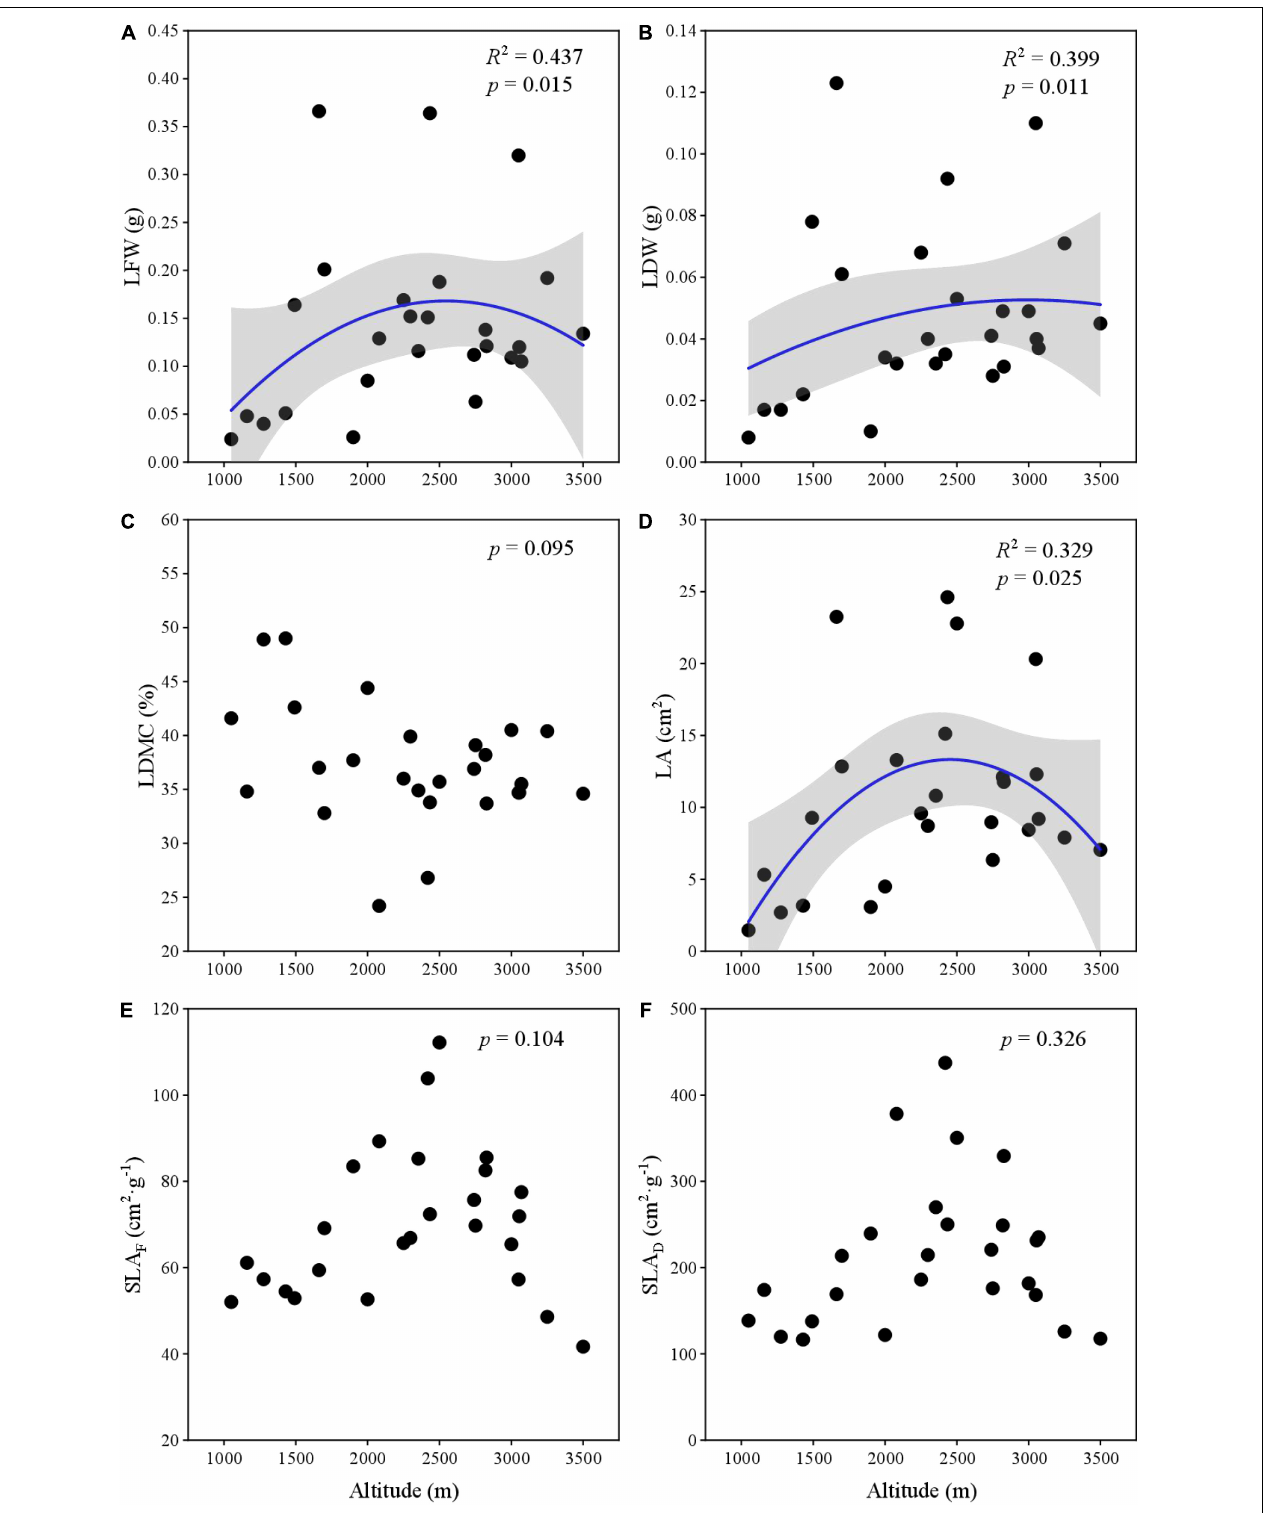
FIGURE 2 | The variation of leaf traits along elevation gradient. (A) LFW; (B) LDW; (C) LDMC; (D) LA; (E) SLA F -based fresh weight; and (F) SLA D -based dry weight.